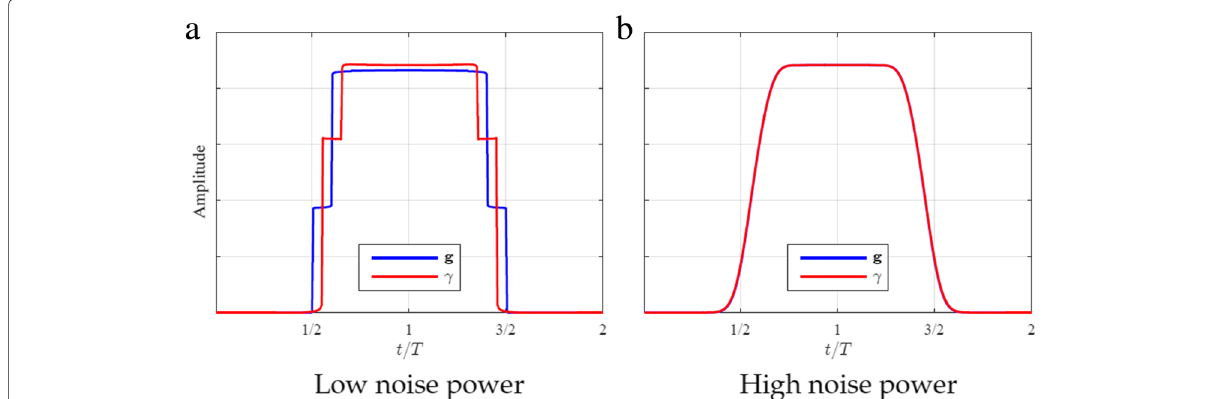
Fig. 14 a , b Pulse shapes designed for time-variant